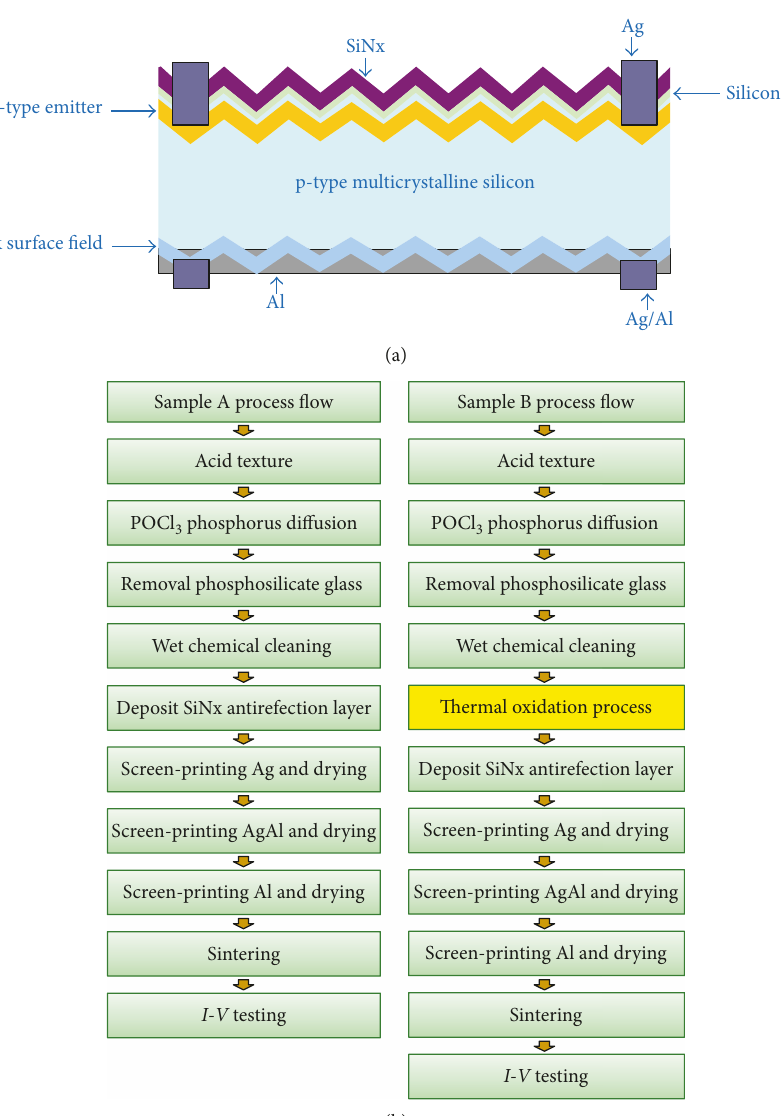
Figure 1: (a) The cross section of the completed multicrystalline silicon solar cell and (b) fabrication process fl ow of the multicrystalline silicon solar